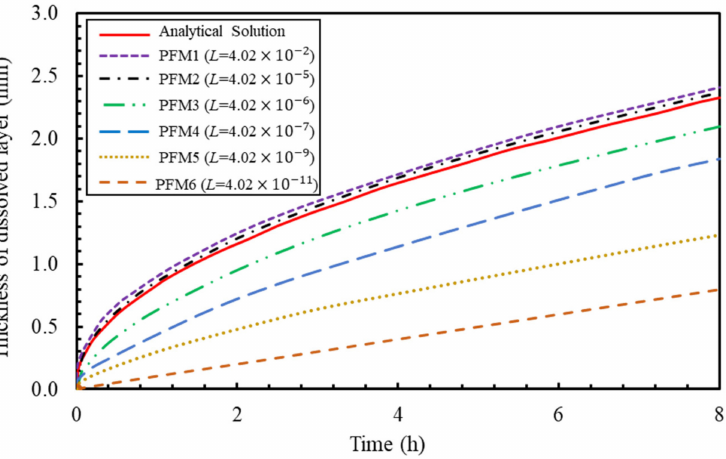
Figure 4. Comparison of analytical and phase-field (PF) model results of a dissolving planar mineral with variation of interface mobility L , to shift from the fastest diffusion controlled mechanism towards the slower ones limited by reaction